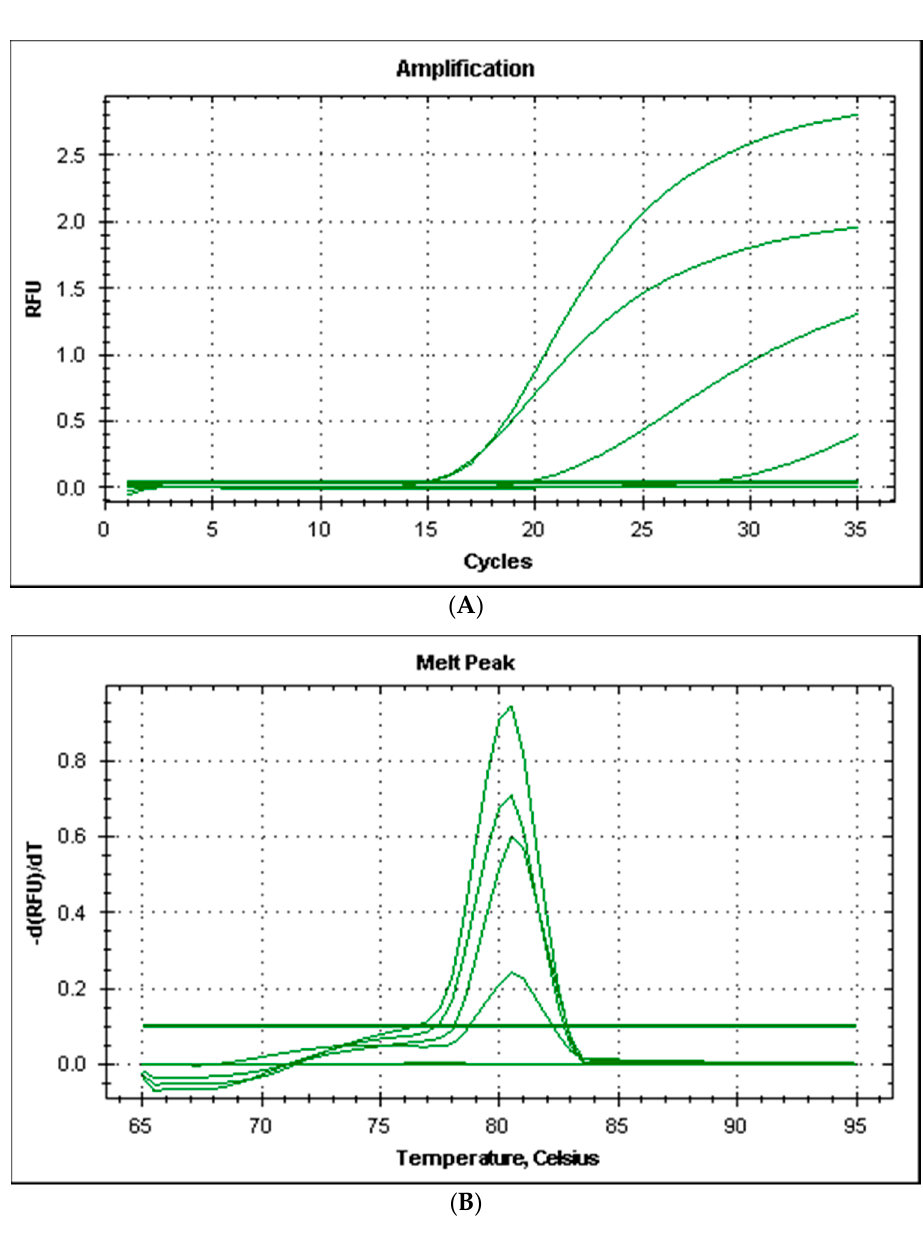
Figure 2. Amplification plot ( A ) and melt curves ( B ) from rt-PCR of histidine decarboxylase gene of Photobacterium damselae subsp. damselae.